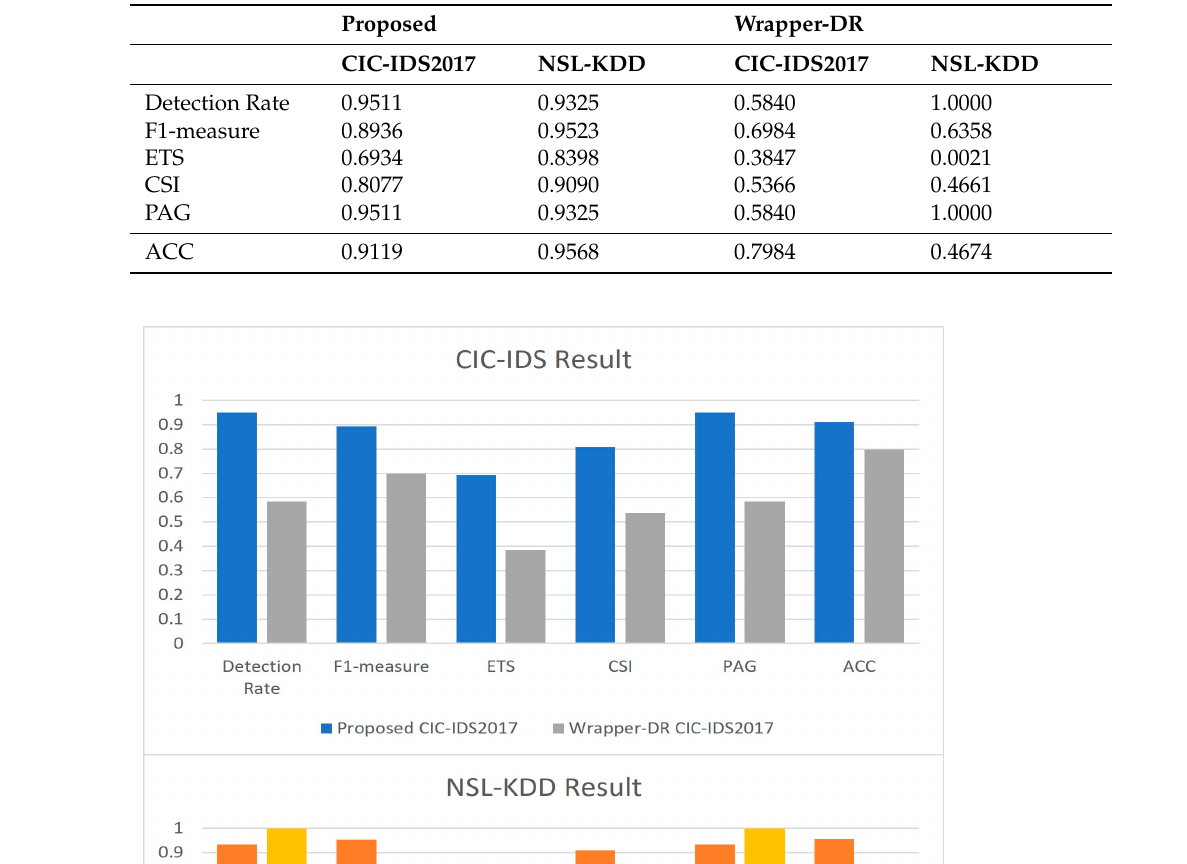
Table 8. Result of binary decoding: table (CIC-IDS 2017/NSL-KDD dataset).